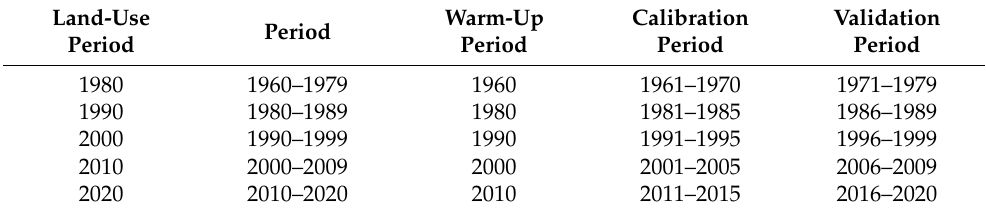
Table 2. Classification of model time